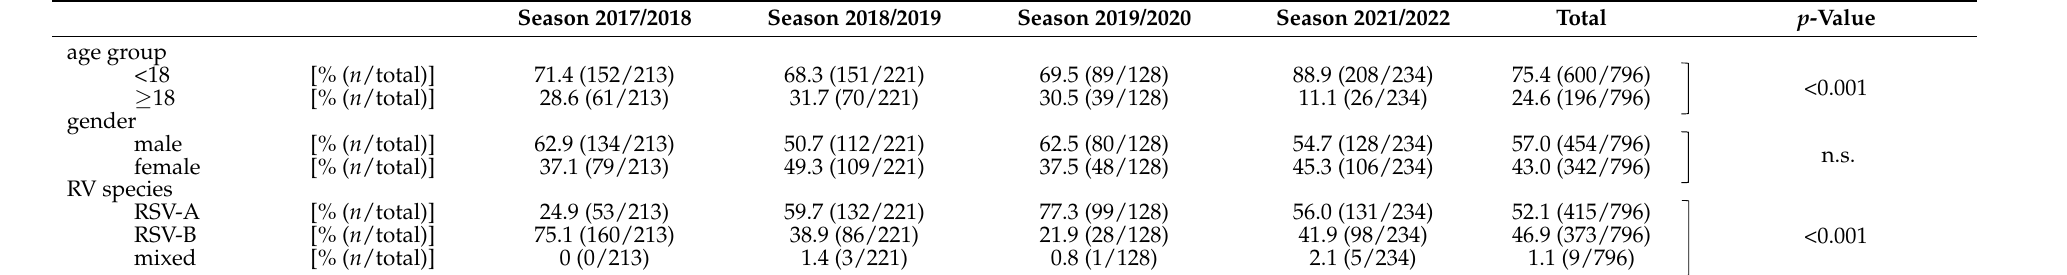
Table 1. Gender, age, and RSV species distribution during the study period.